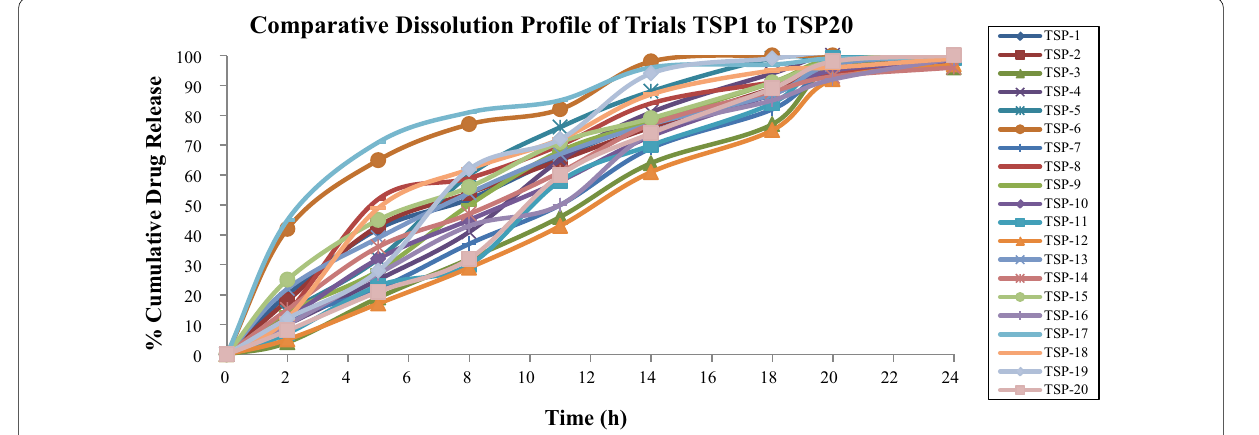
Fig. 2 In vitro dissolution and release kinetics of DOE batches trospium chloride PPOP